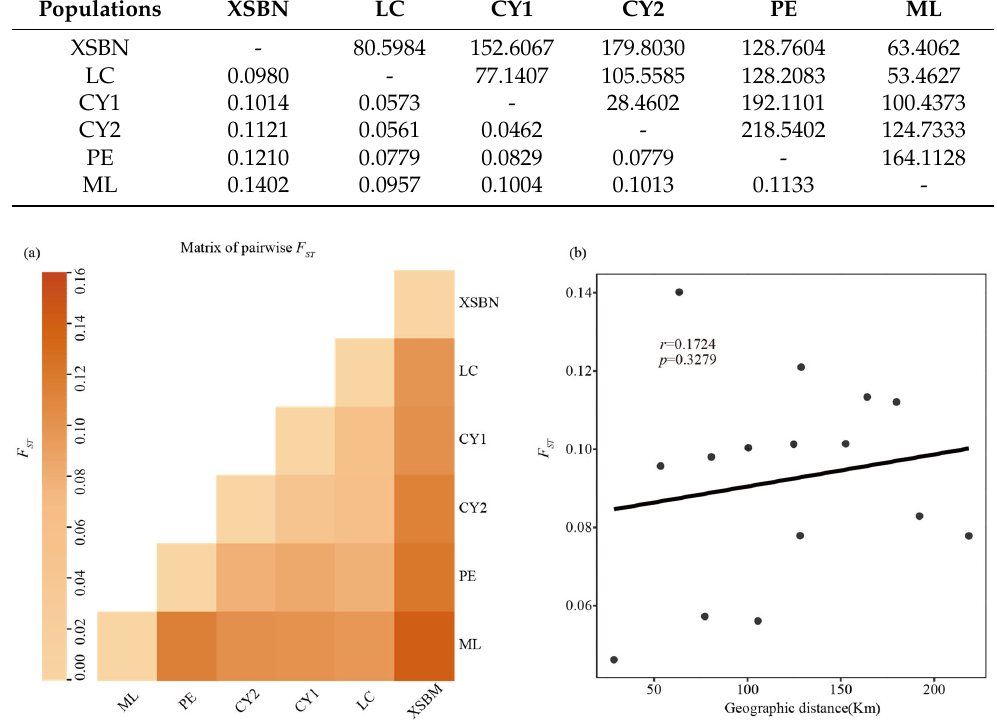
Table 3. Genetic distance and geographic distance between populations of T. doichangensis . Below diagonal: genetic distance among populations ( F ST ). Above diagonal: geographic distance between populations (km).